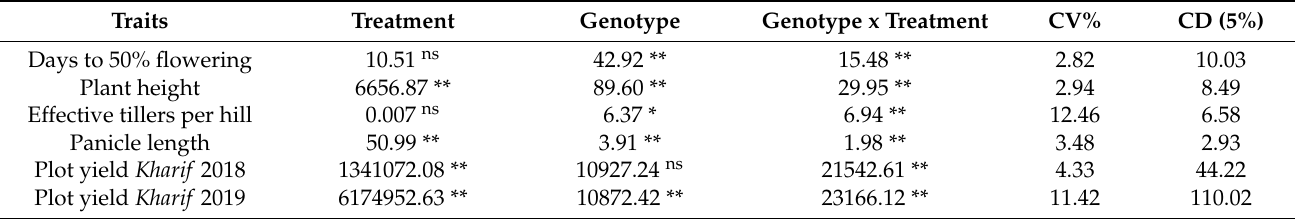
Table 3. Combined analysis of variance among the Pusa 44 NILs carrying qDTY12.1 under irrigated (US) and drought stress (S) during Kharif 2018 and Kharif